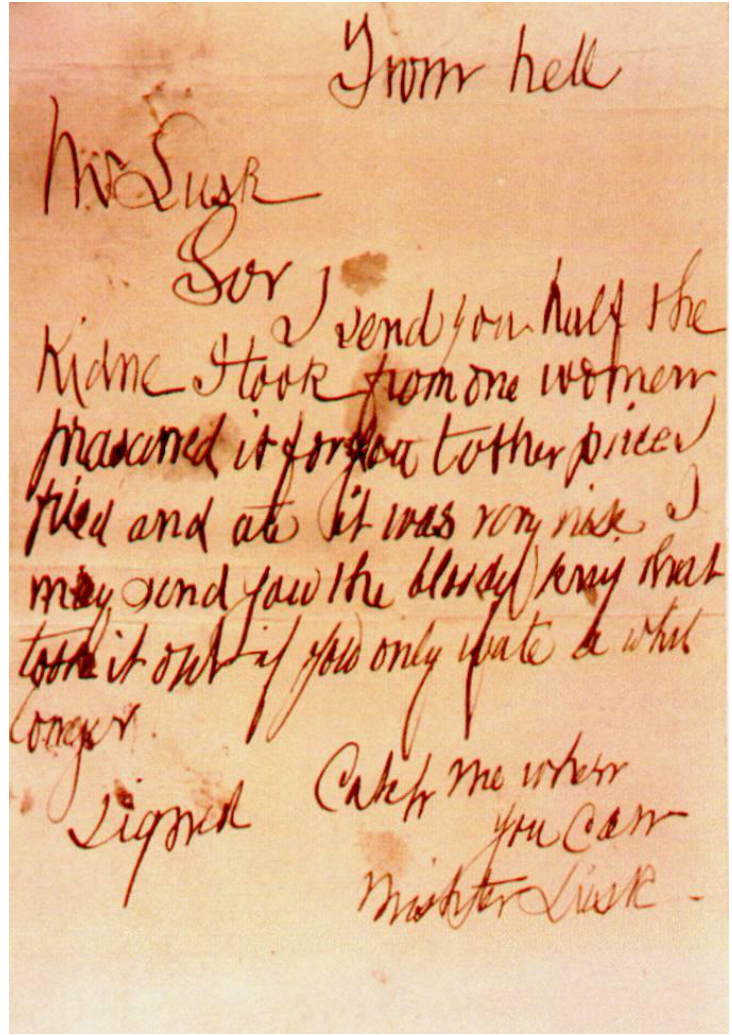
Figure 5. Letter purportedly from Jack the Ripper (Anon. (n.d.). A photographic copy of the now lost “From Hell” letter, postmarked 15 October 1888 [27].